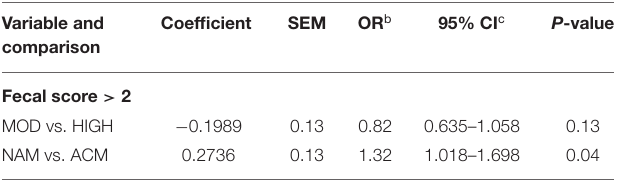
TABLE 7 | Logistic models for the likelihood of experiencing diarrhea (Fecal score > 2 a ) during preweaning (day 2–56) for calves fed moderate (6L) or high (12L) volumes of milk with (ACM) or without (NAM)